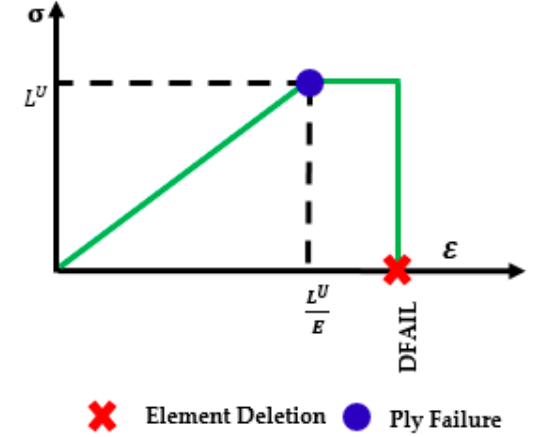
Figure 14. Elastic-plastic stress-strain behavior of MAT54.